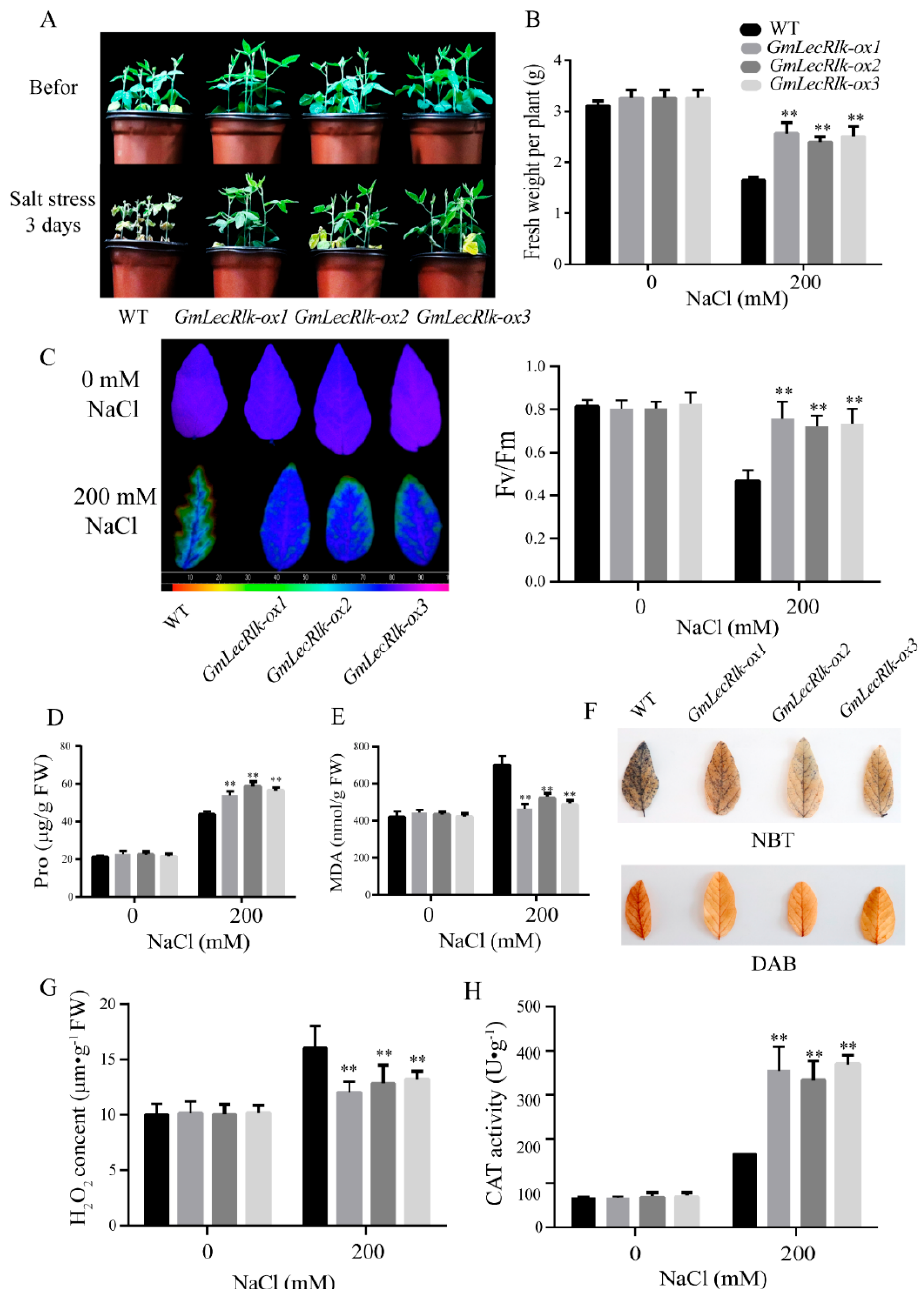
Figure 3. GmLecRlk improves salt tolerance in soybean. ( A ) Phenotypic analysis of GmLecRlk -ox and WT soybean under 200 mM NaCl; ( B ) fresh weight in GmLecRlk -ox and WT soybean with 0 or 200 mM NaCl; ( C ) Fv/Fm rate in GmLecRlk -ox and WT soybean with 0 or 200 mM NaCl. ( D,E , G ) Pro, MDA, and H 2 O 2 content in GmLecRlk -ox and WT soybean with 0 or 200 mM NaCl. ( F ) GmLecRlk -ox and WT soybean leaves were stained with NBT and DAB under 200 mM NaCl for 3 days. ( H ) CAT activity in GmLecRlk -ox and WT soybean with 0 or 200 mM NaCl. **, GmLecRlk -ox soybean showed a significant difference from the WT ( p < 0.01). Error bars, s.e.m.